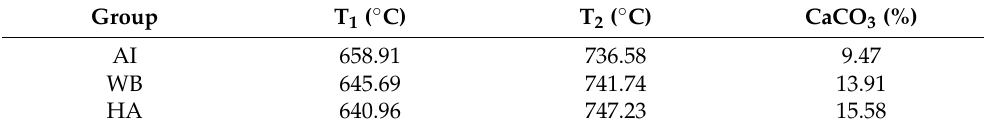
Table 2. The mass percentage content of calcium carbonate in the carbonation layer of the samples.